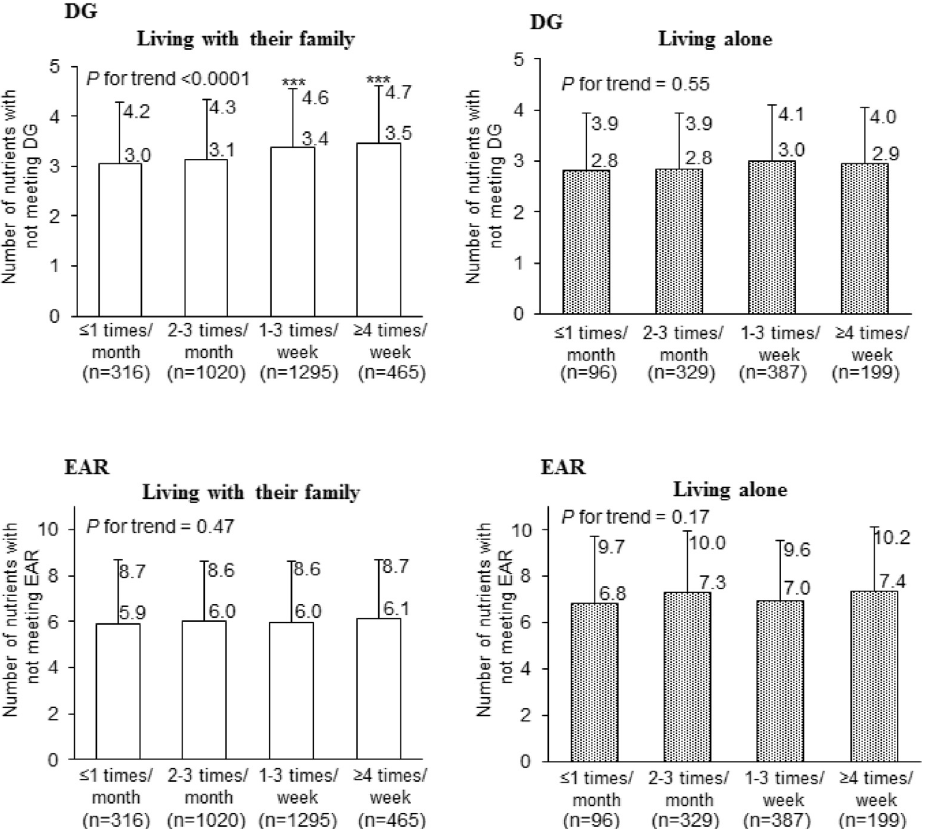
Fig. 2. The number of nutrients with not-meeting DG and EAR according to the frequency of eating out-of-home foods among 4,107 adult women living with their family or living alone. A linear trend test was used with the median value in each categoryof the frequency of eating out-of-home foods (0.2, 0.6, 2.5, and 5.0 times/week for those living with their family and 0.2, 0.6,1.0, and 5.0 times/week for those living alone, respectively) as a continuous variable in linear regression. Signi fi cance level with a value of (cid:4) 1 times/month was compared using Dunnett's test (*** P < 0.001). DG, tentative dietary goal for preventing lifestyle-related disease; EAR, estimated average